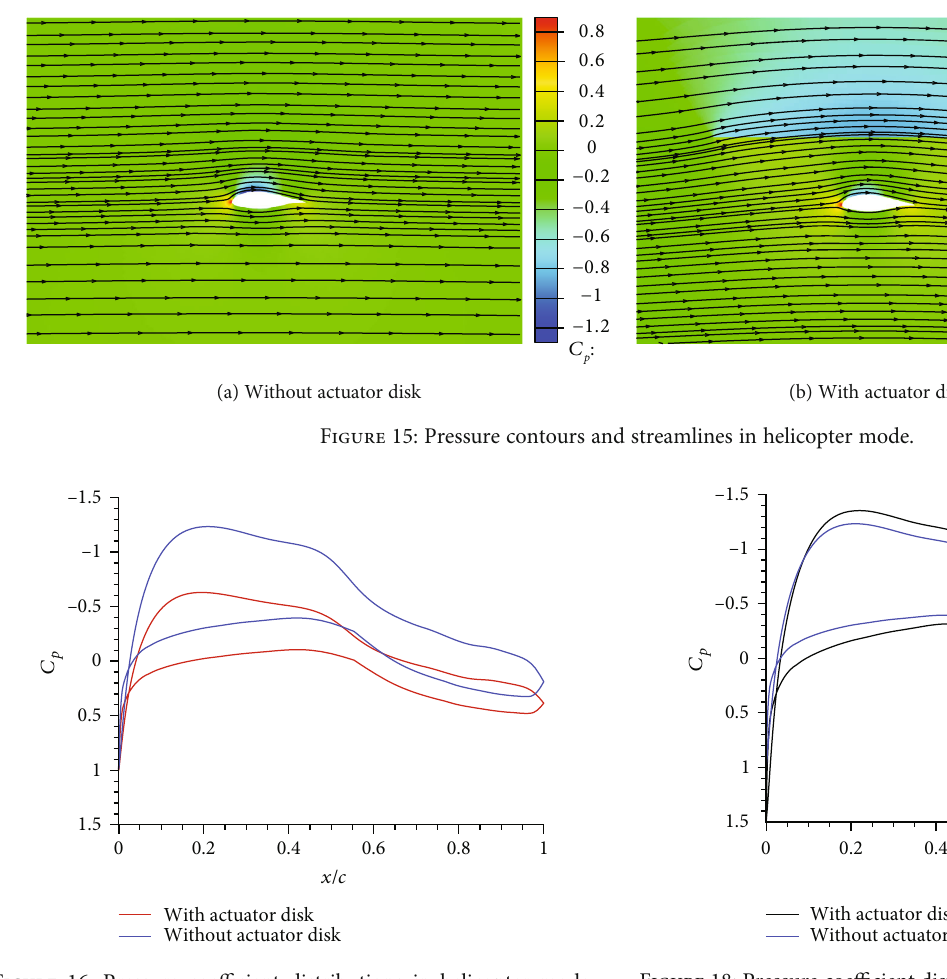
Figure 16: Pressure coe ffi cient distributions in helicopter mode, with and without actuator disk.